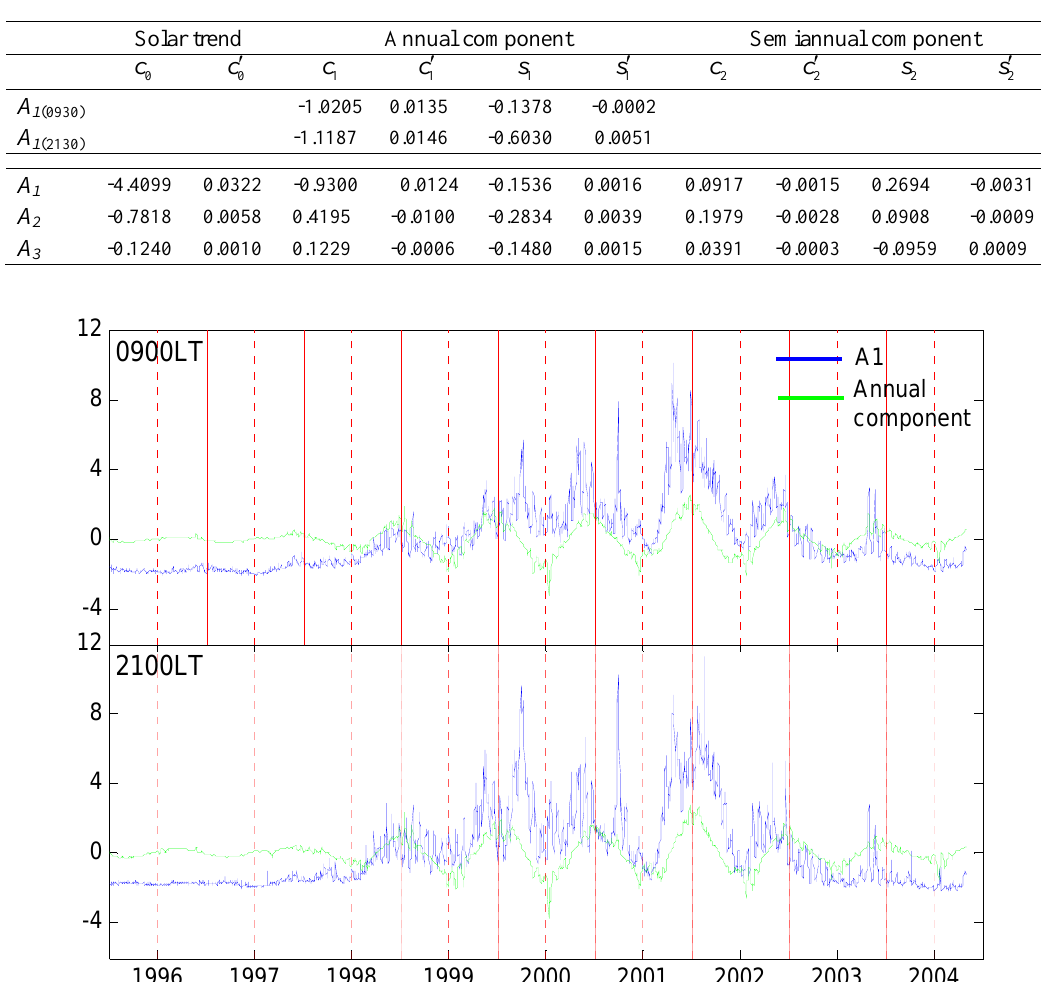
Fig. 8. A1 coefficient and its associated annual component (derived from Eq. 3) for 09:30 LT and 21:30